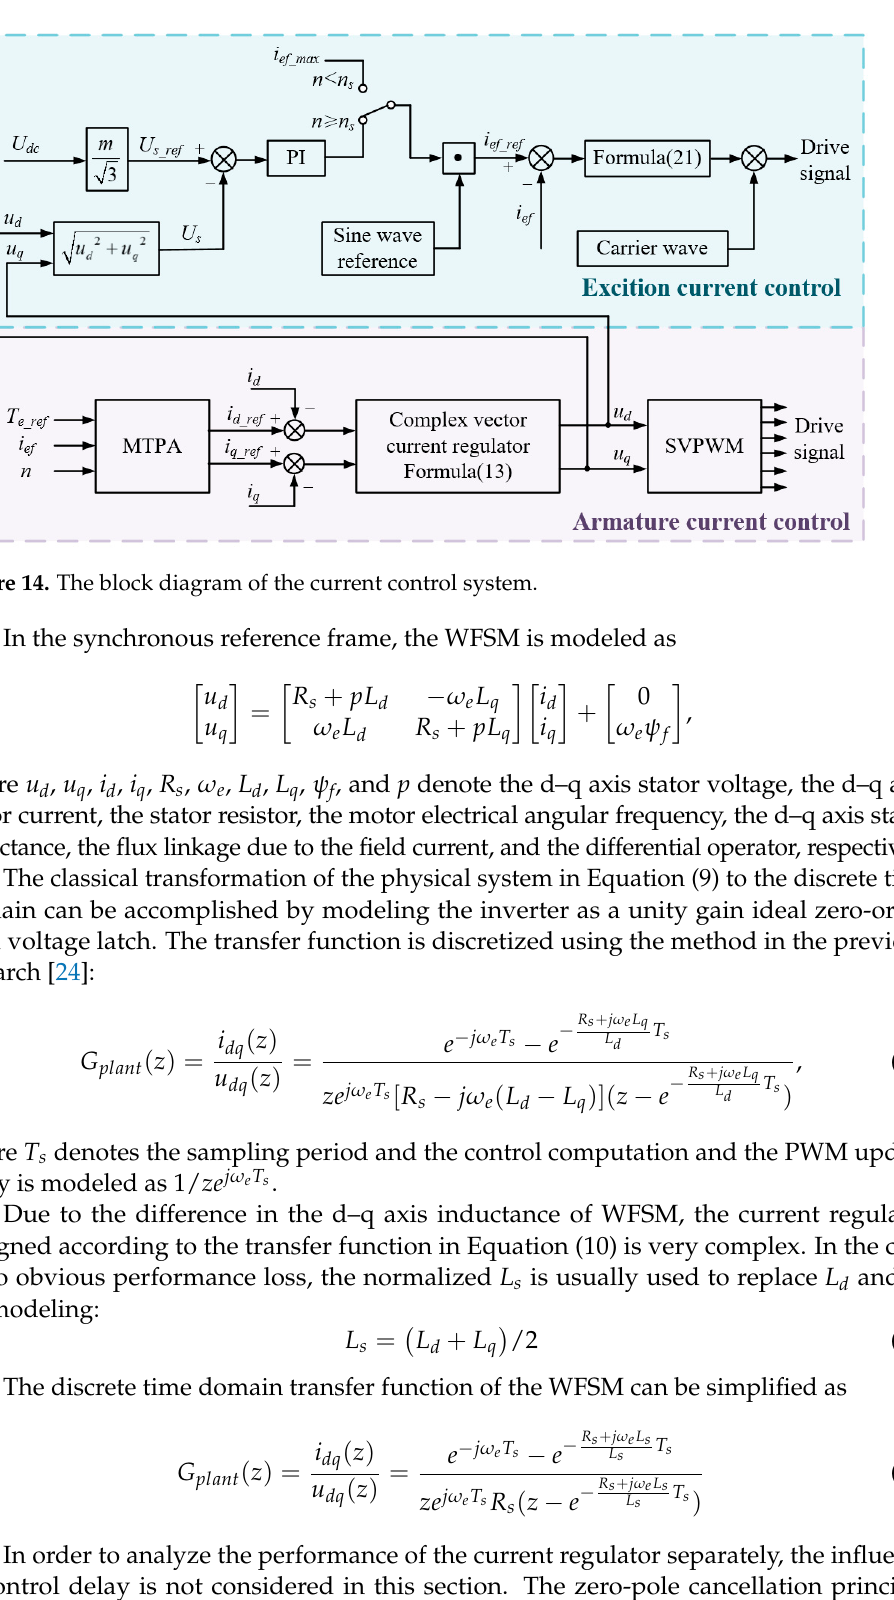
Figure 13. Vector diagrams of the 1st and 2nd quadrant operation: ( a ) 1st quadrant operation; ( b ) 2nd quadrant operation.